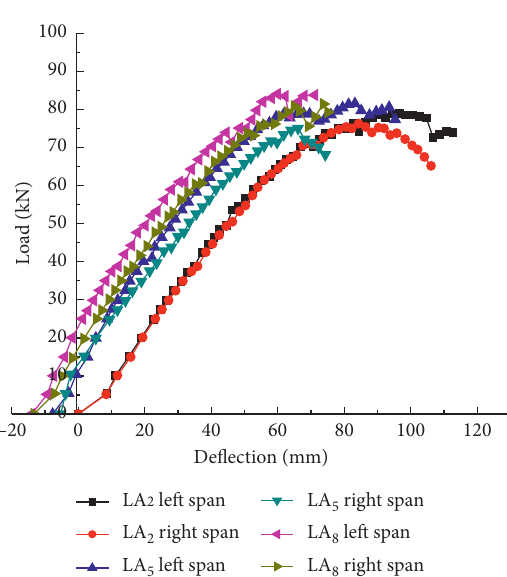
Figure 12: Load-deflection curves of beams with four steel